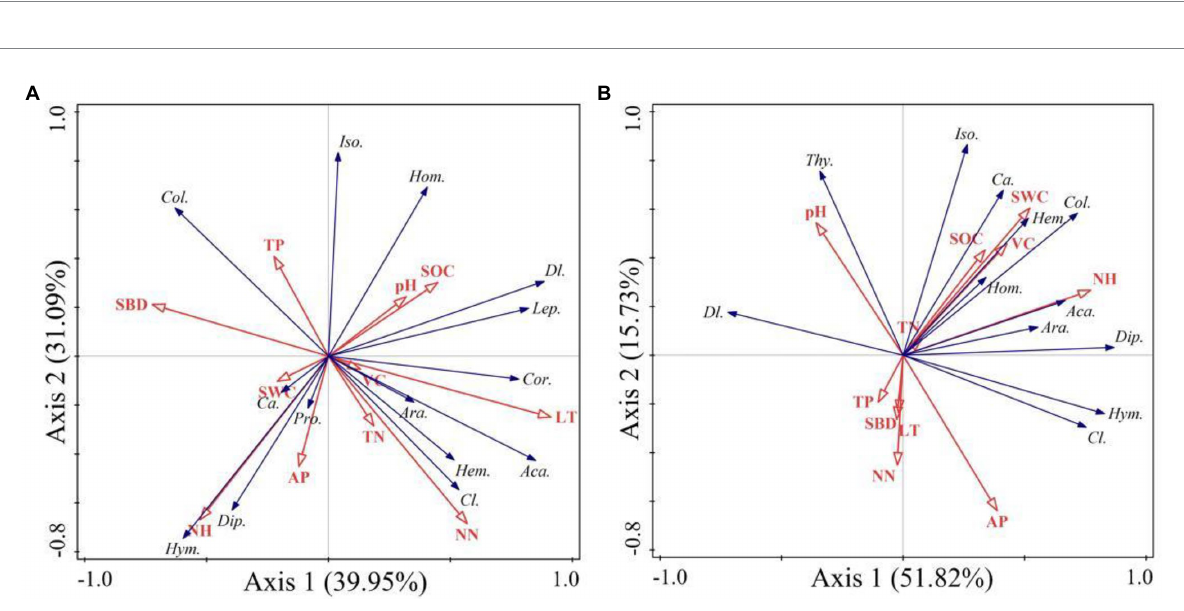
FIGURE 8 Redundancy analysis (RDA) showing the relationship between soil arthropods composition and environment factors ( A is the burned habitats; B is the unburned habitats). Ara., Araneae; Aca., Acari; Pro., Protura; Col., Collembola; Dip., Diplura; Iso., Isoptera; Hem., Hemiptera; Thy., Thysanoptera; Cor., Corrodentia; Cl., Coleoptera larvae; Ca. , Coleoptera adult; Lep., Lepidoptera larvae; Dl., Diptera larvae; Hym., Hymenoptera; Hom.,